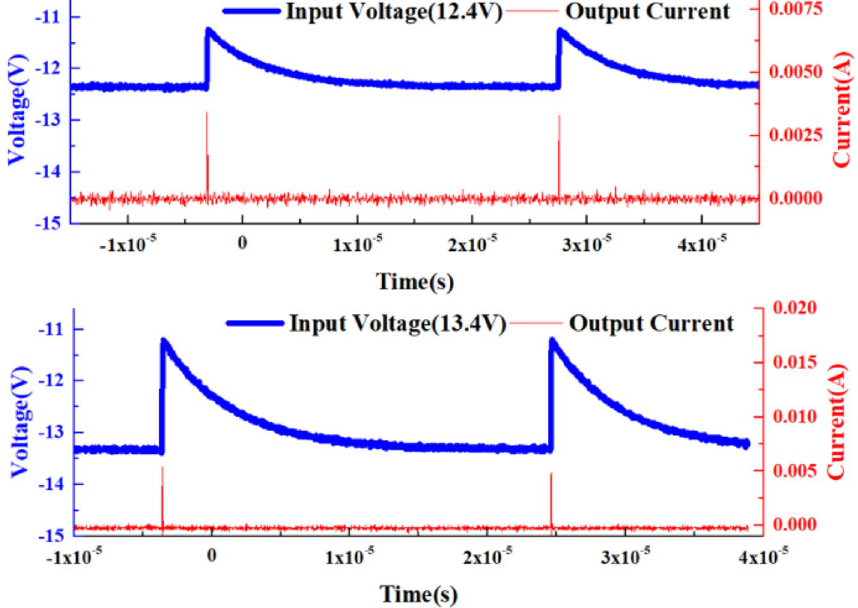
Figure 10. Test voltage–time curve and test current–time curve (12.4 V, 13.4 V) of VADTS under the excitation of multisegment pulse signals.